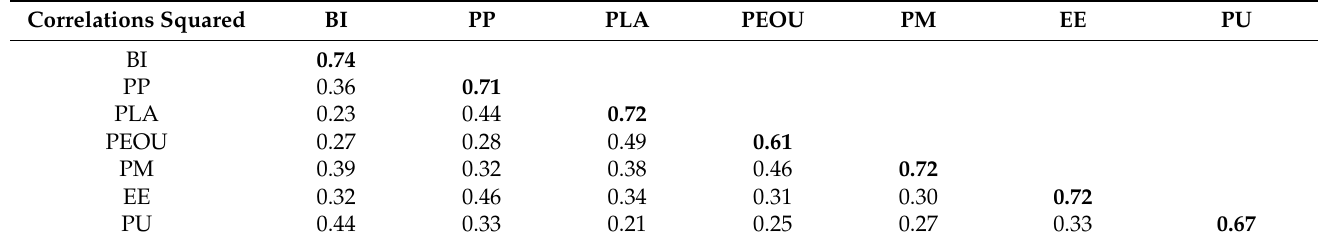
Table 7. Discriminant Validity.